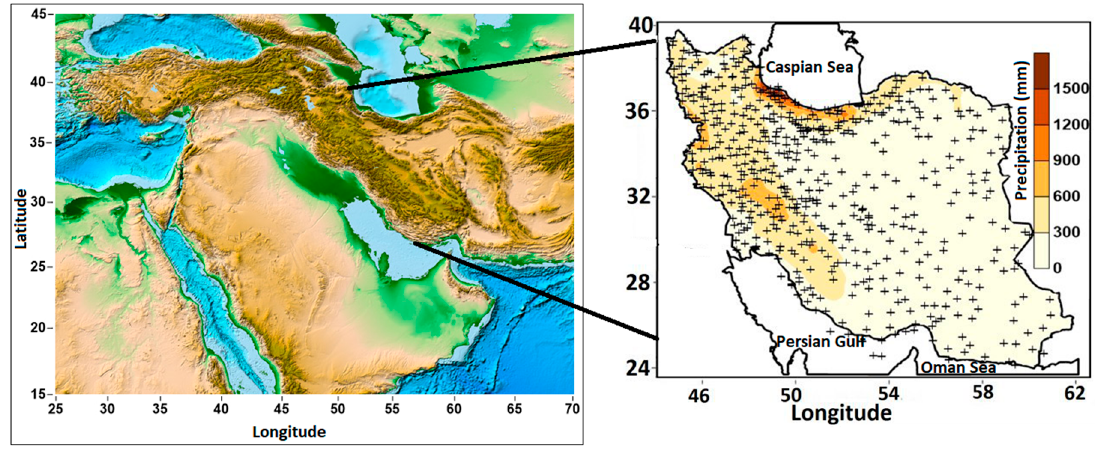
Figure 1. The study regions (Middle East) (A), Annual average precipitation (mm) distribution in Iran during 1951–2010 (shading), and the locations of all meteorological stations (+).